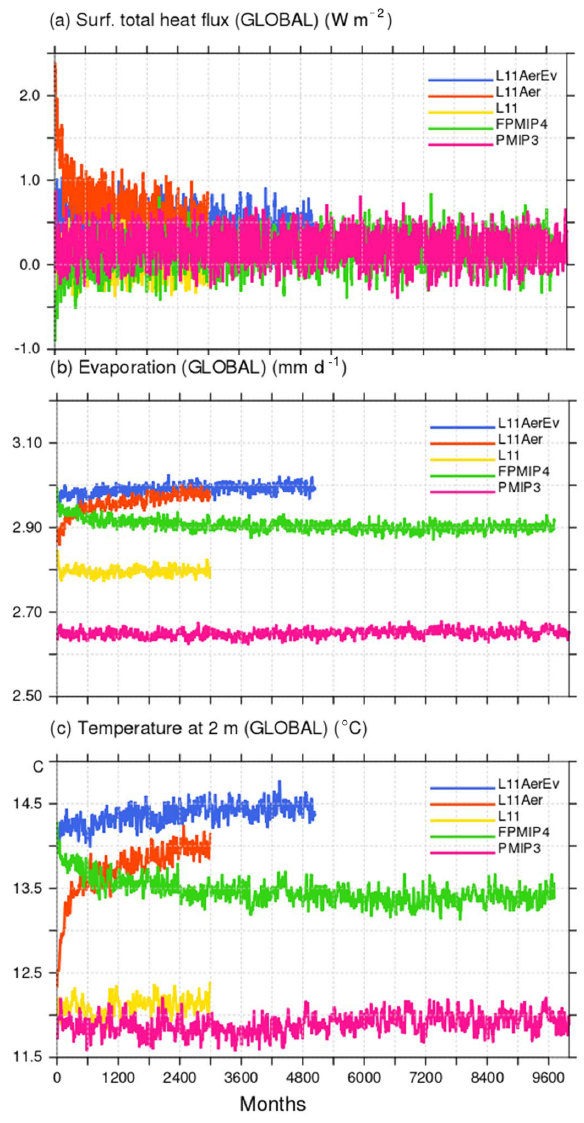
Figure 1. Illustration of the effect of the different adjustments made to produce Mid-Holocene simulations with the modified version of the IPSLCM5A-MR model in which the land surface model OR- CHIDEE includes a different soil hydrology and snow models (see text for details). The three panels show the global average of (a) net surface heat flux (Wm − 2 ), (b) evaporation (kgm − 2 ), and (c) 2m air temperature ( ◦ C). The different colored lines represent the re- sults for the different simulations reported in Table